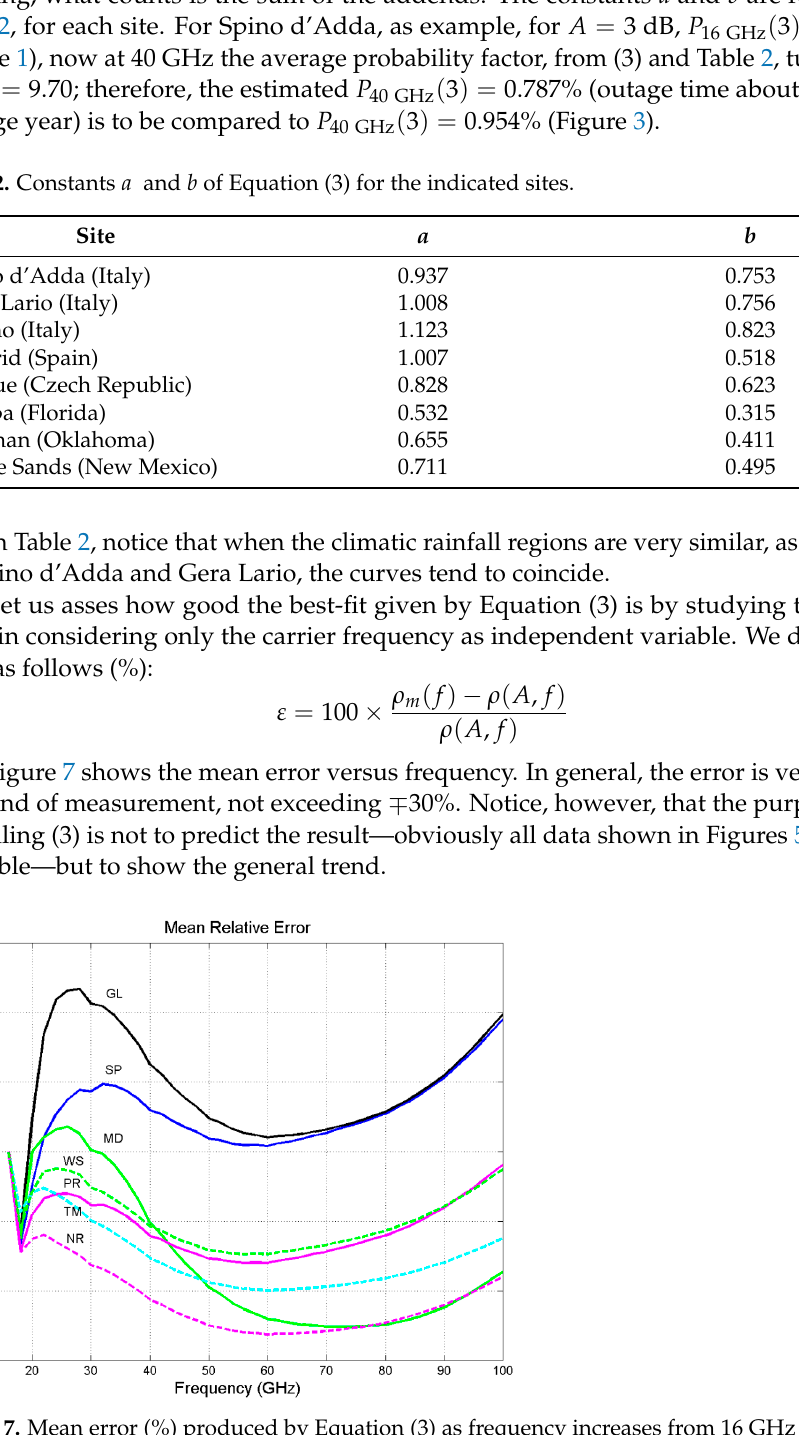
Figure 7. Mean error (%) produced by Equation (3) as frequency increases from 16 GHz to 100 GHz. Spino d’Adda (SP, blue continuous line); Gera Lario (GL, black continuous line); Madrid (MD, green continuous line); Prague (PR, magenta continuous line); Tampa (TM, cyan dashed line); Norman (NR, magenta dashed line); White Sands (WS, green dashed line).